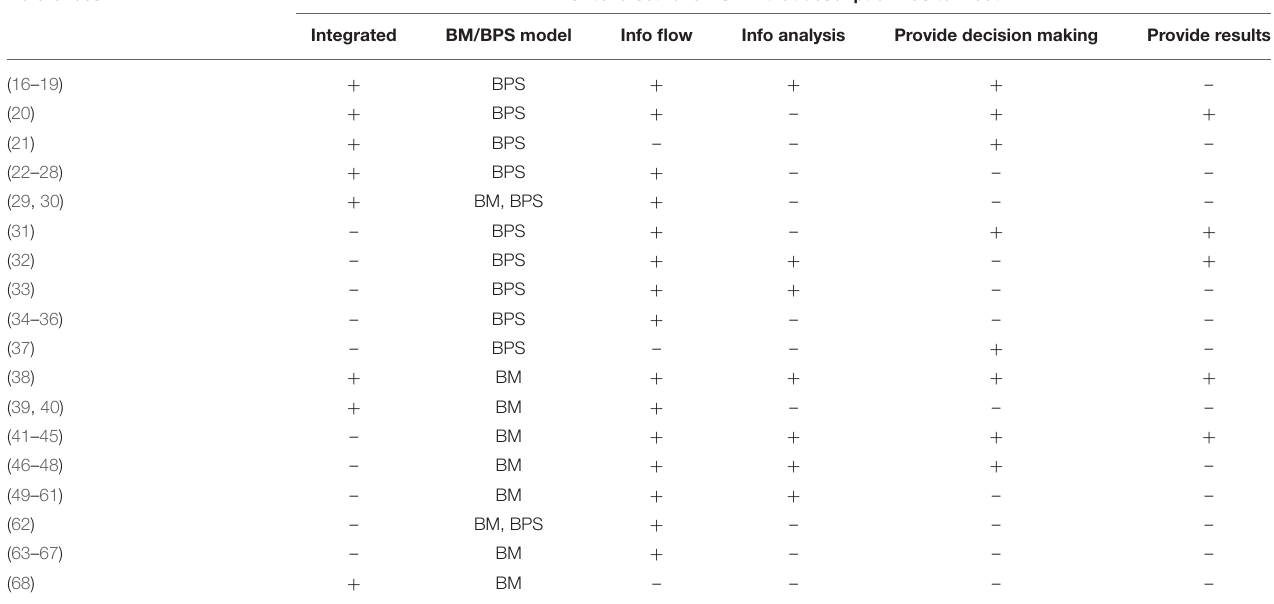
TABLE 1 | Publications on automated systems for personalized health management found in patent and non-patent literature ranked by their correspondence to criteria for a self-sufficient integrated solution (criteria are described in section Sources of Information About Current Practices in Automated Systems for Personalized Health Management and Search